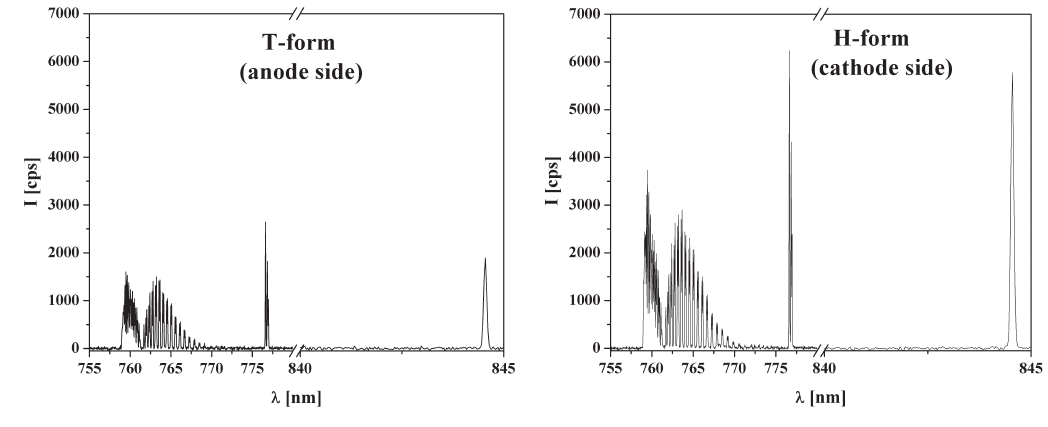
Figure 3: Examples of the emission spectra of both forms ( p =650 Pa, I =20 mA).